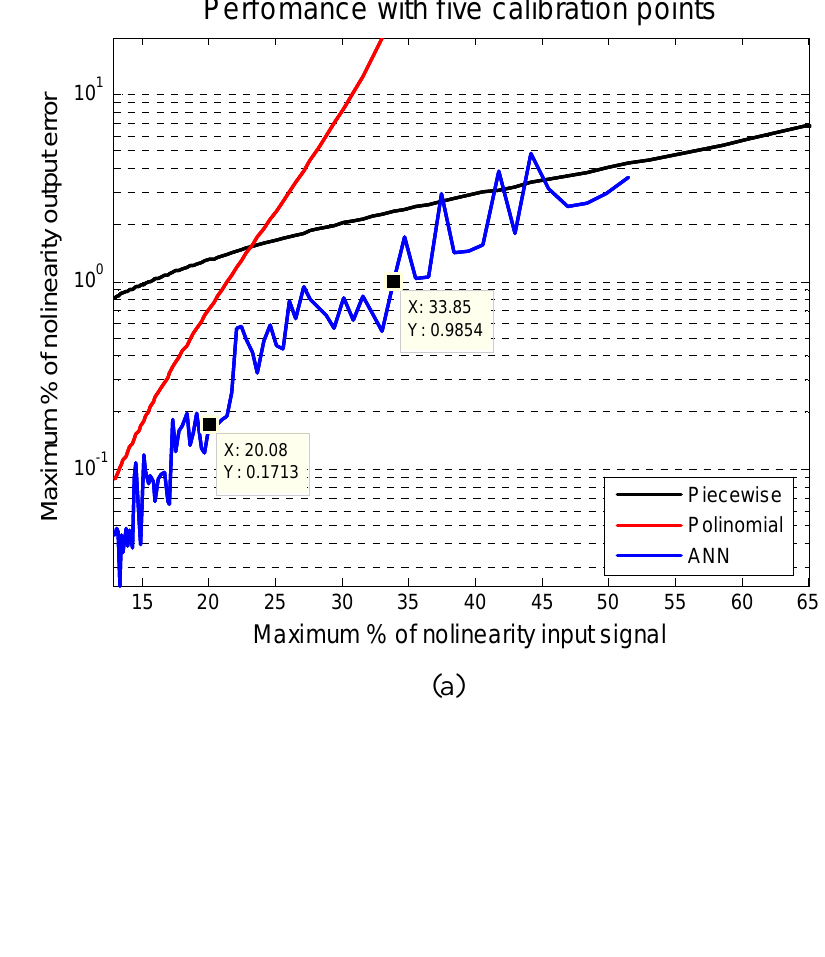
Figure 3 . Performance of the ANN to self-calibration. a) With five calibration points, b) with six calibration points c) with seven calibration points and d) with eight calibration